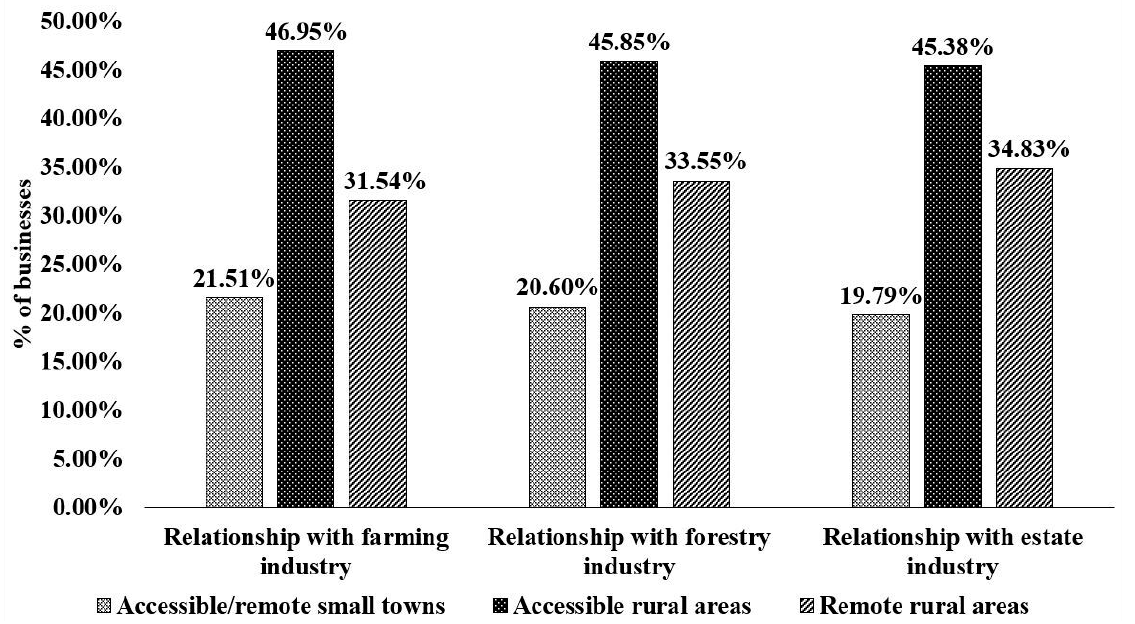
Figure 3. Relationships with land-based industry by rural town classification. Table 1 details the descriptive statistics of key variables used in the analysis, including both dependent and independent variables. For example, with regard to non-land-based rural businesses, 27.6% of the non-land-based businesses in rural areas were located in Aberdeenshire, followed by the Borders (26.8%) and Dumfries and Galloway (21.9%). Approximately 46% and 35% of these businesses were family businesses and women-led businesses, respectively. Moreover, 40% of the non-land-based rural businesses were older businesses operating for 25 years and over, while only 7.7% were young businesses less than 5 years of